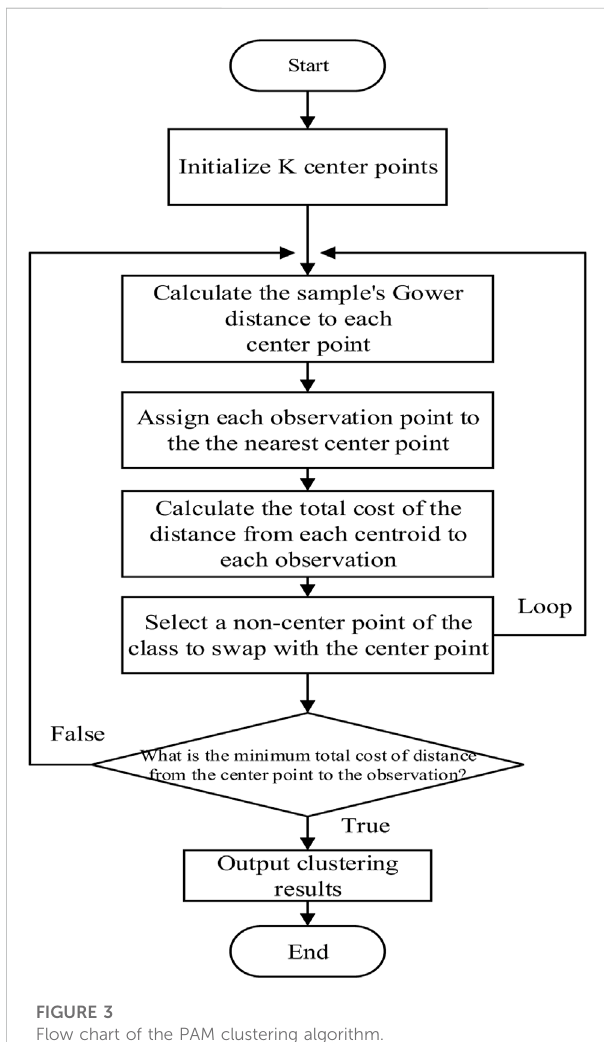
FIGURE 3 Flow chart of the PAM clustering